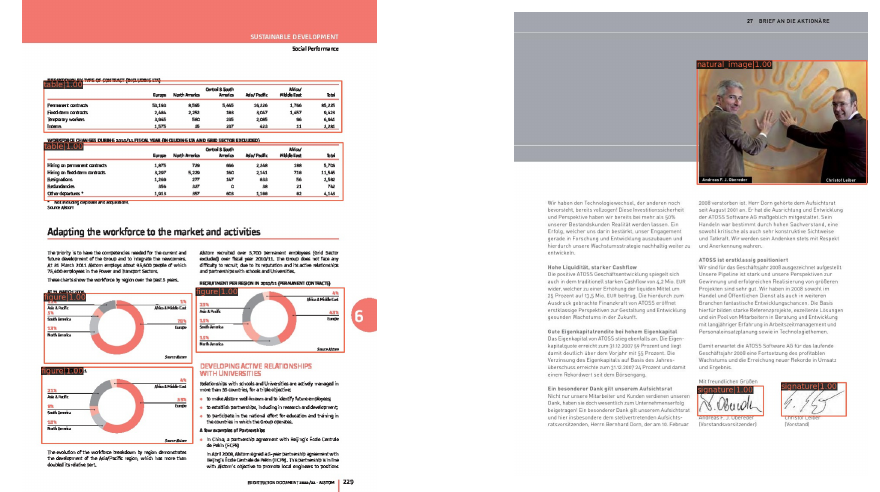
Figure 2. Left : graphical objects Table and Figure. Right : graphical objects Natural image and Signature. Both the images are generated by the the Soft Teacher model, which is trained on 5% of the labeled IIIT-AR-13K